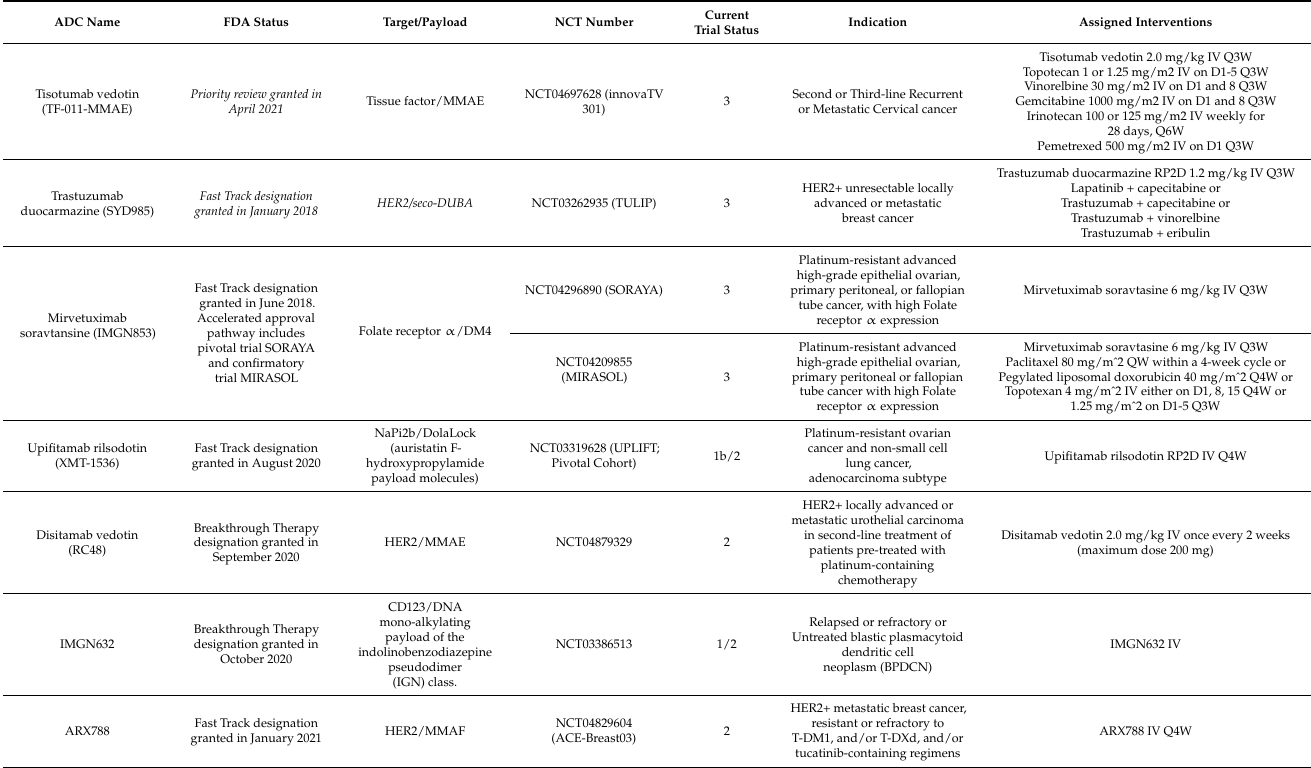
Table 2. Summary of non-approved ADCs that have been granted breakthrough therapy designation, fast-track designation or priority review by the US FDA and their current clinical trial